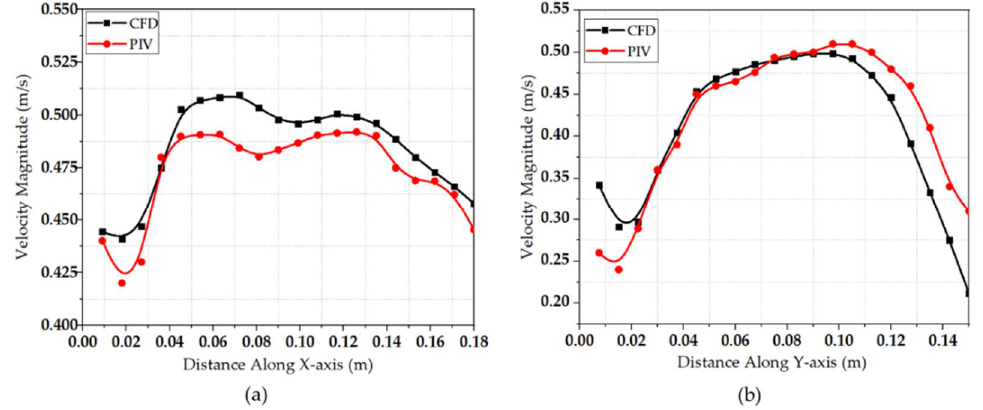
Figure 11. Velocity vectors: ( a ) PIV and ( b ) CFD simulation.